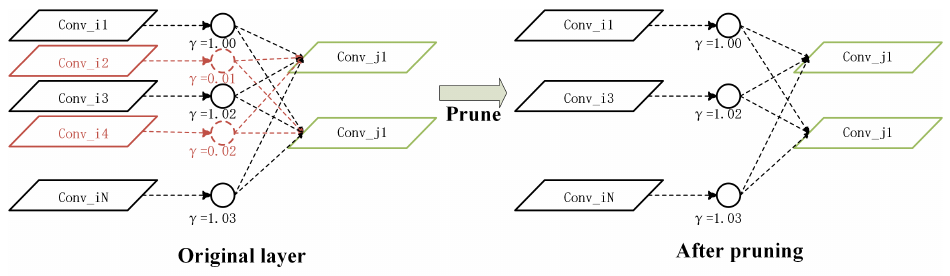
Figure 3. Schematic diagram of channel